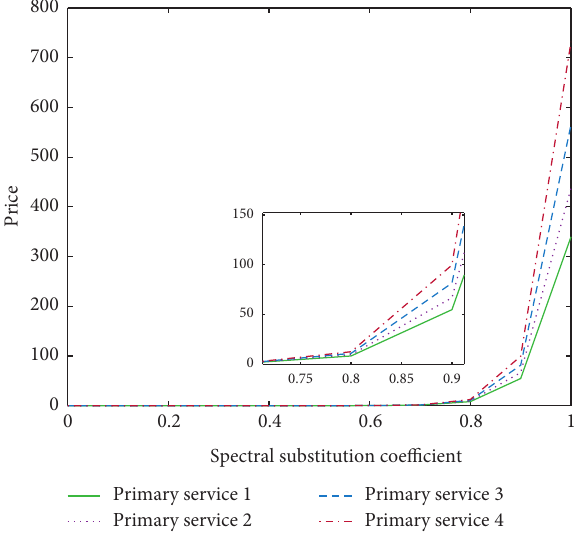
Figure 7: The relationship between price and spectral substitution coefficient for four PSPs.